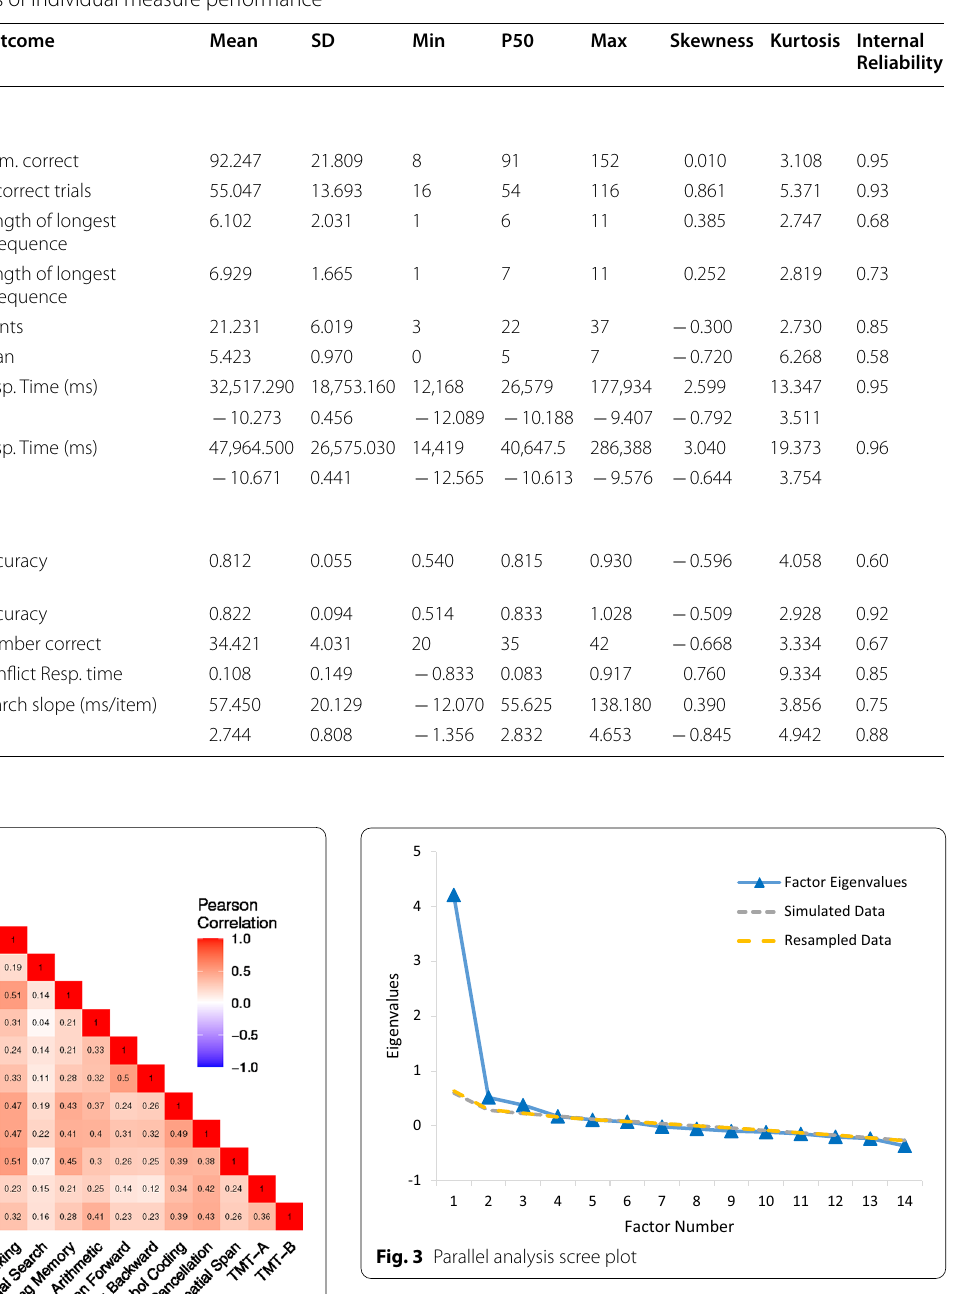
Table 2 Descriptive statistics of individual measure performance